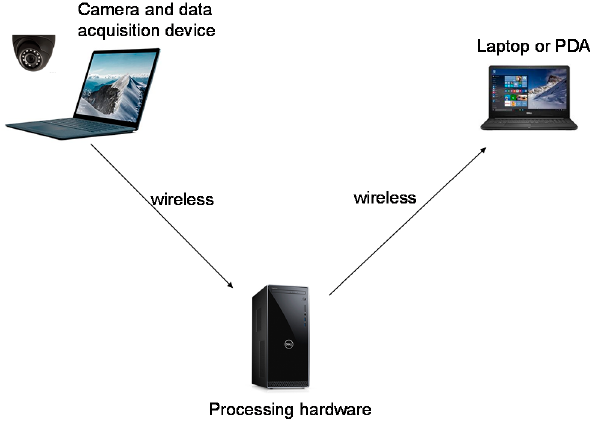
Figure 4. Relationship between camera, processing hardware, and display devices (laptop or personal digital assistant (PDA)).